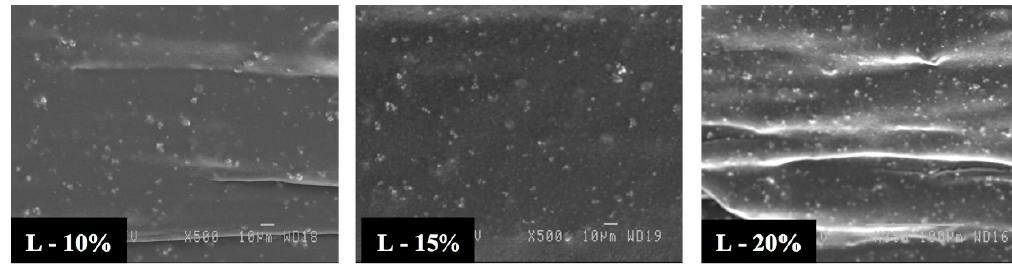
Figure 3. High-resolution images showing zeolite nanoparticle dispersion in the matrix.